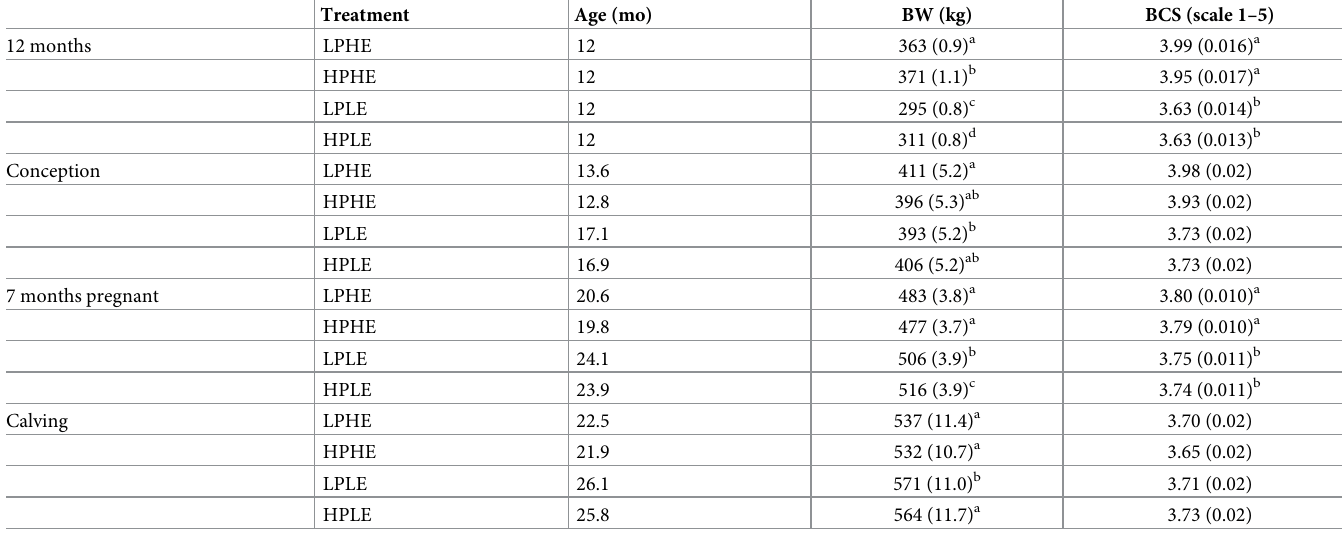
Table 2. Least square means of body weight (BW) and body condition score (BCS) at 12 months of age, conception, 7 months of pregnancy and